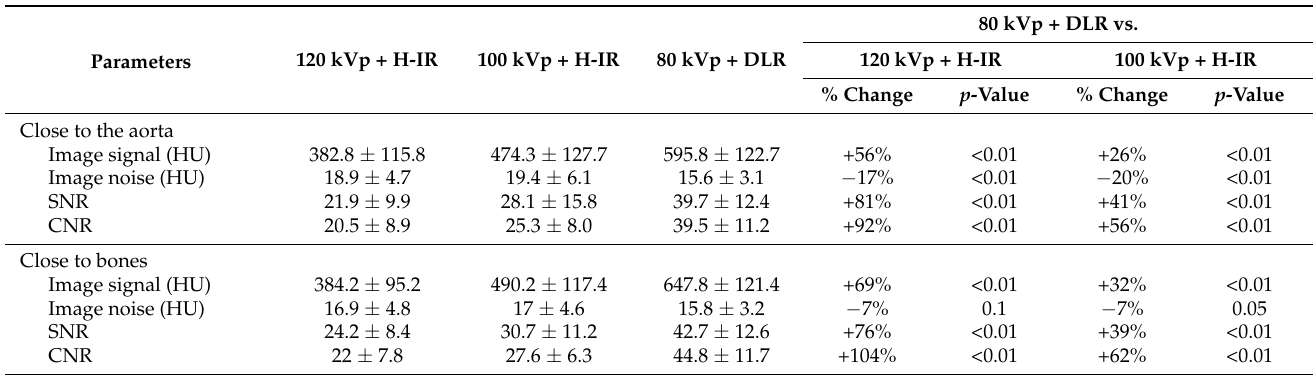
Table 6. Quantitative image analysis at regional levels of low-kVp protocol with DLR vs. higher-kVp protocol with